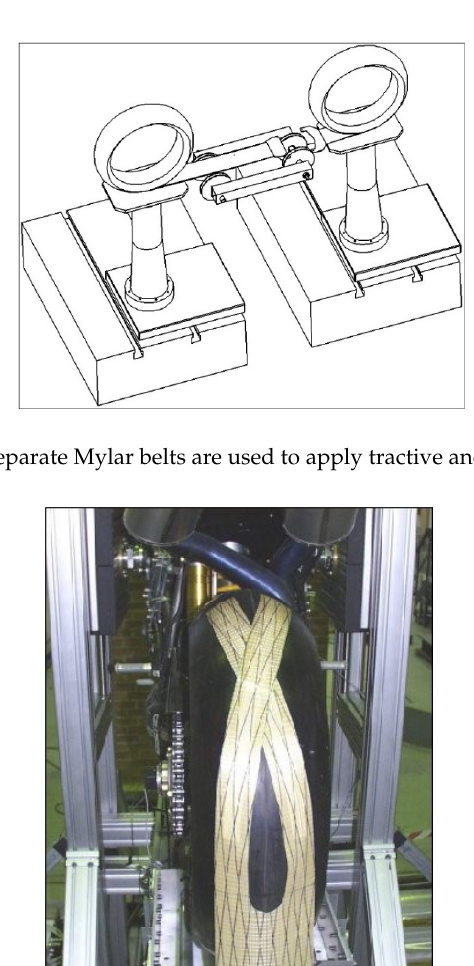
Figure 9. The actual setup of the Mylar belt as bonded to one tyre.